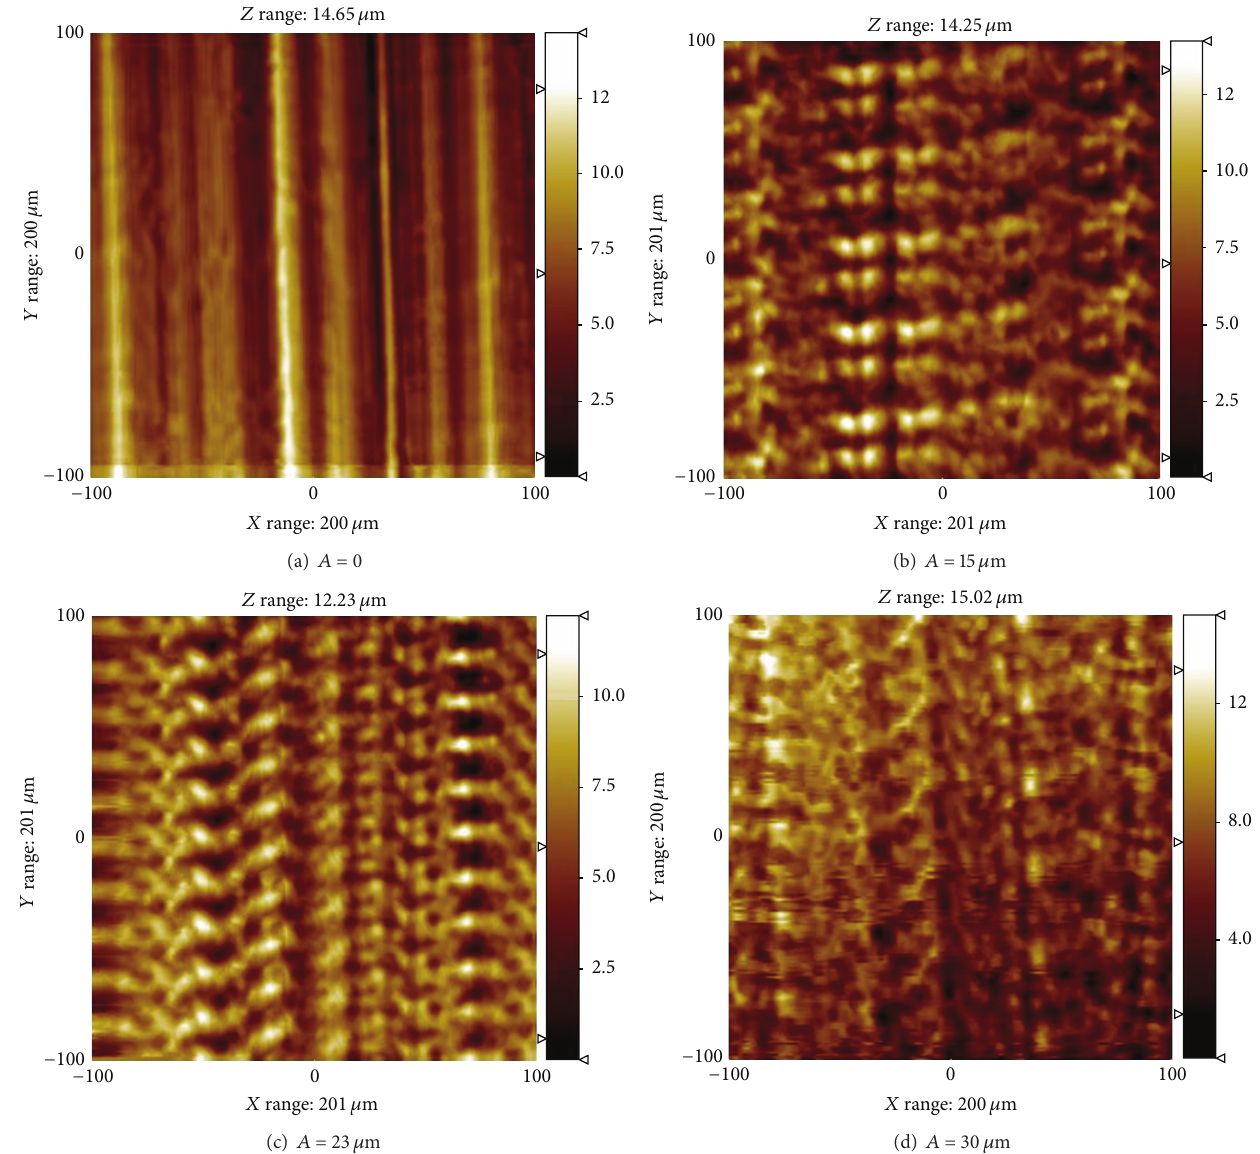
Figure 15: Surface microtopography of machined workpiece under different ultrasonic